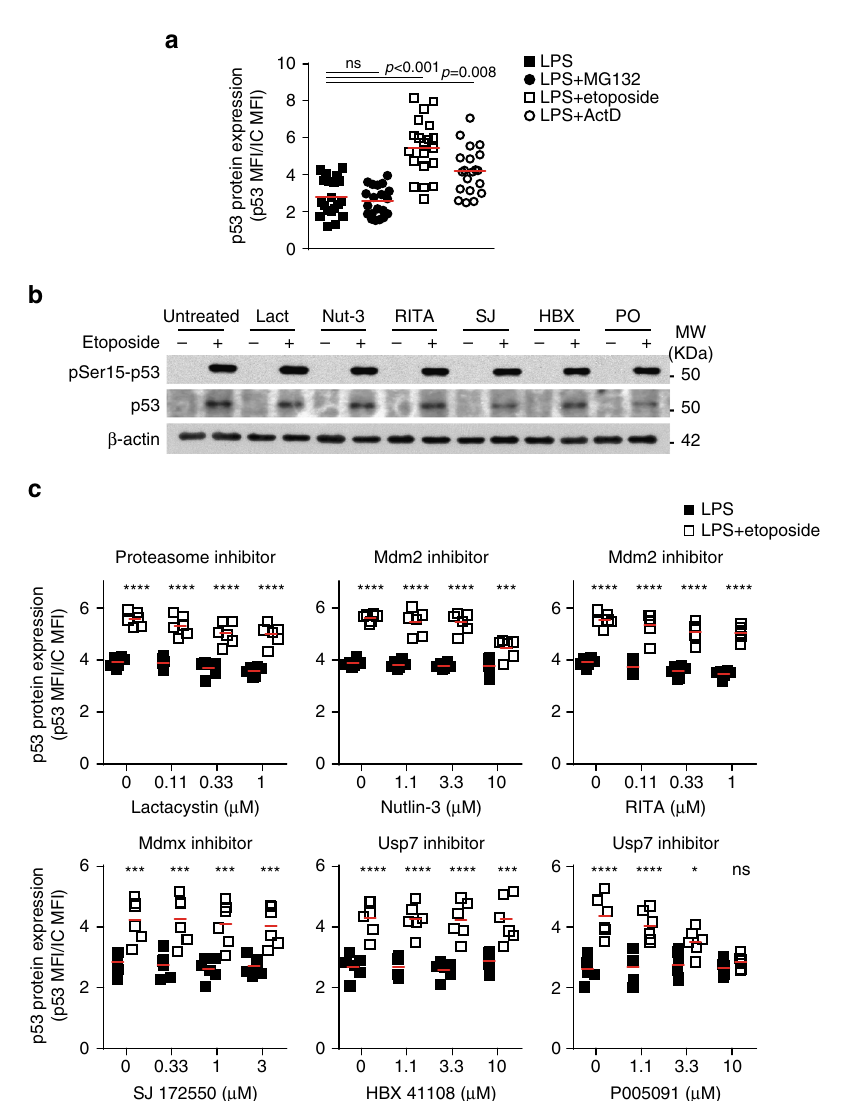
Fig. 7 Proteasome does not regulate p53 protein synthesis in B cells. a Quantitation by fl ow cytometry of p53 protein expression in LPS-activated B cells treated with MG132 (10 μ M), etoposide (20 μ M) or actinomycin D (ActD, 5 μ g ml − 1 ). Data are from six independent experiments with 2 to 4 biological replicates in each. Mann – Whitney test was performed. b Immunoblot analysis of pSer15-p53, p53 and β -actin in activated B cells treated with Lactacystin (Lact, 1 μ M), Nutlin-3 (Nut-3, 10 μ M), p53 Activator III RITA (1 μ M), SJ172550 (SJ, 1 μ M), HBX41108 (HBX, 10 μ M) or P005091 (P0, 10 μ M) prior induction of DNA damage with etoposide. One of the two independent experiments performed is shown. c Quantization by fl ow cytometry of p53 expression in B cells treated with different doses of the inhibitors described in b . Data are from six biological replicates collected in two independent experiments. Two-way ANOVA and Bonferroni post-test analysis was performed ( ns non-signi fi cant, * P < 0.05, *** P < 0.001, **** P < extended cellular mechanism that modulates protein synthesis in response to DNA damage and interrogated the polysome distribution of Hif1 α and H2-K1, two other targets of Tia1 (Supplementary Fig. 8A, B) that were identi fi ed as having an increased translation once maintaining their mRNA abundance (Fig. 4d). Similarly, to p53, Hif1 α and H2-K1 mRNA distribution in heavy polysomes signi fi cantly increased after B cell treatment with etoposide (Supplementary Fig. 8C, D). The polysome pro fi le of Hif1 α was restored upon ATM inhibition and, like p53, resembled the one in control B cells (Supplementary Fig. 8C). The effect of ATM inhibition in H2-K1 mRNA polysome distribution was inconclusive although it might suggest that H2-K1 mRNA shifts to fractions with a lower ribosome occupancy and less translation (Supplementary Fig. 8D). Taken together, our data shows that ATM kinase activation during the DNA damage response modulates Tia1 dissociation from its mRNA targets and